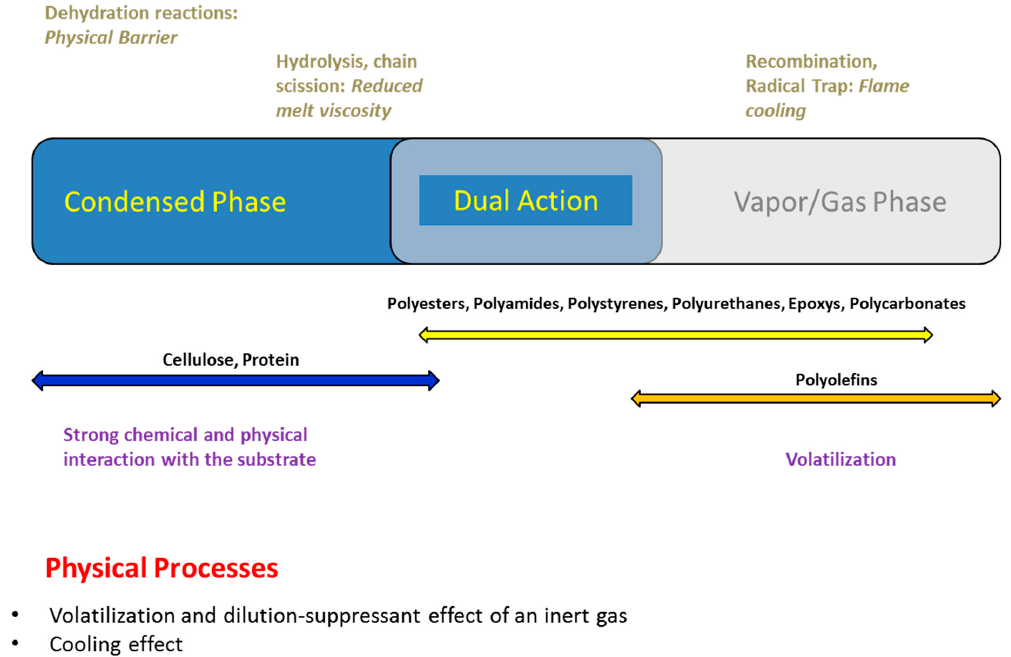
Figure 2. Mode of action of phosphorus-based flame retardants.